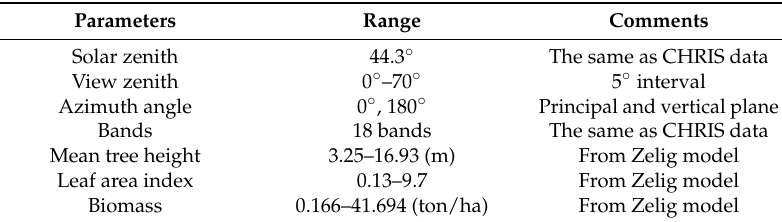
Table 3. Parameters of the look-up